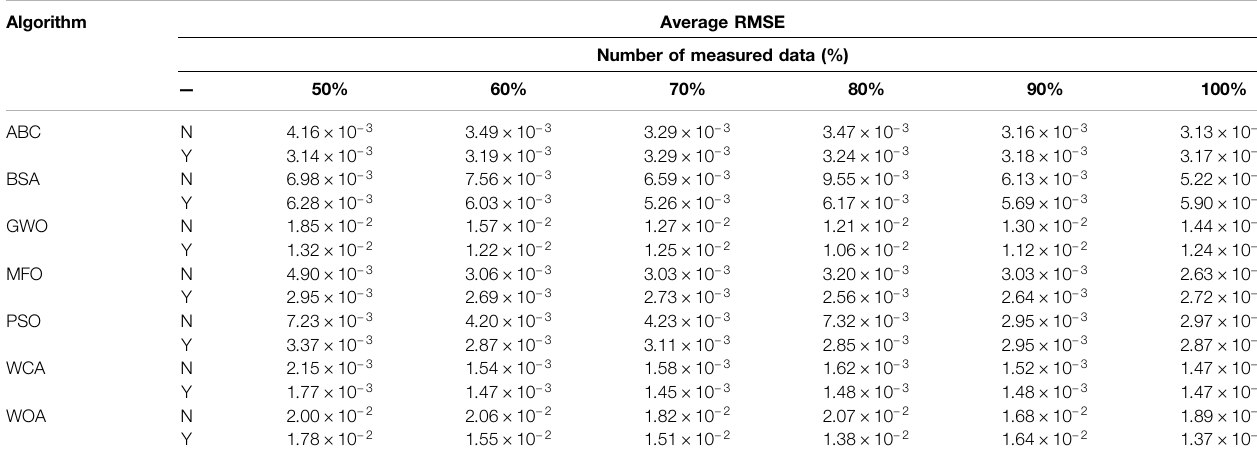
TABLE 5 | Average RMSE obtained by various algorithms for the TDM with six measured data. Algorithm Average RMSE